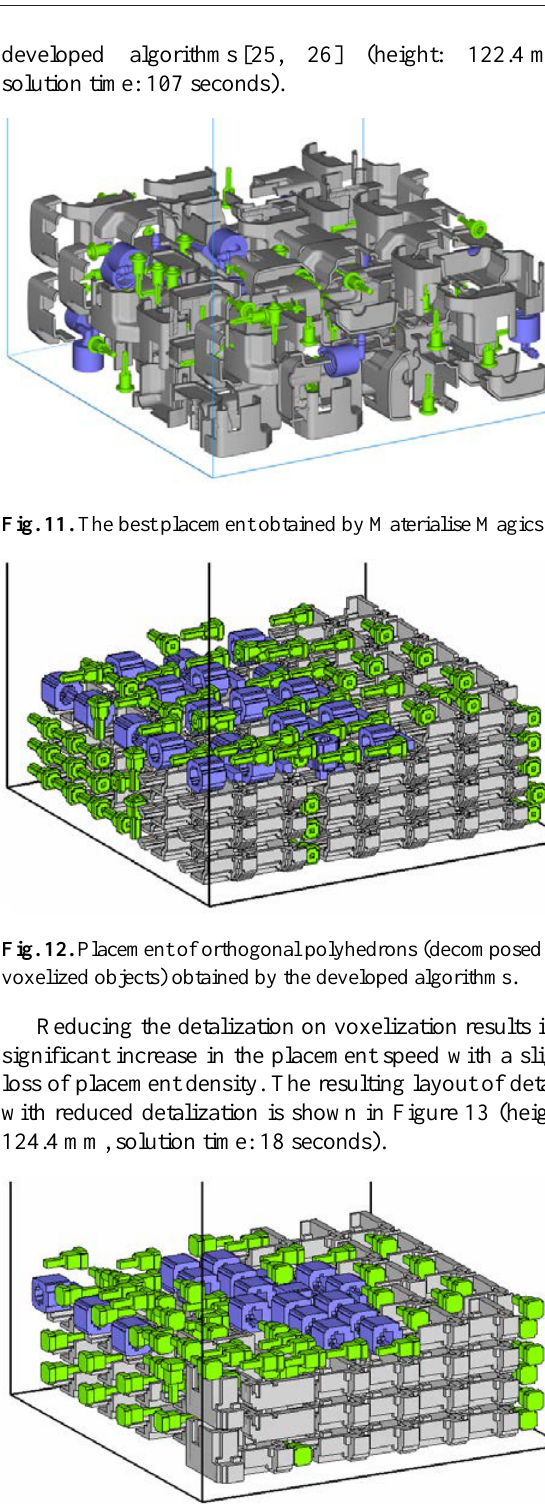
Fig. 13. Placement of orthogonal polyhedrons (decomposed voxelized objects with reduced object detalization) obtained by the developed algorithms